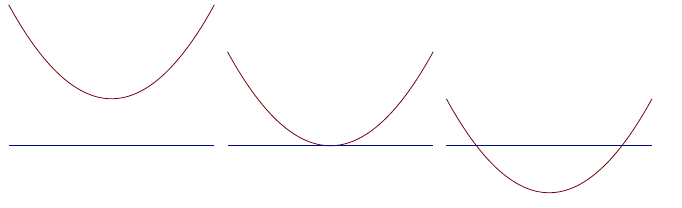
Figure 5. Spectrum branch for the fermionic quasiparticles. The vertical axis is energy. The horizontal axis schematically represents the momentum. ( Left ) Outside of the BH. ( Center ) At the horizon. ( Right ) Inside the